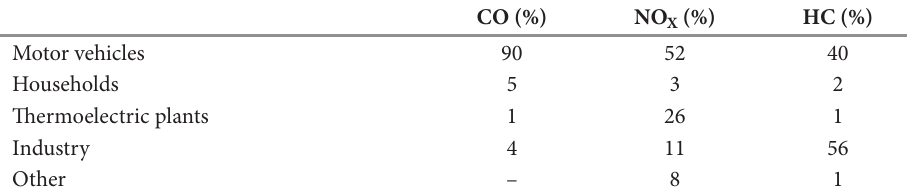
Table 1. Emission of air pollution by sector CO (%) NO X (%) HC (%) Motor vehicles 90 52 40 Households 5 3 Thermoelectric plants 1